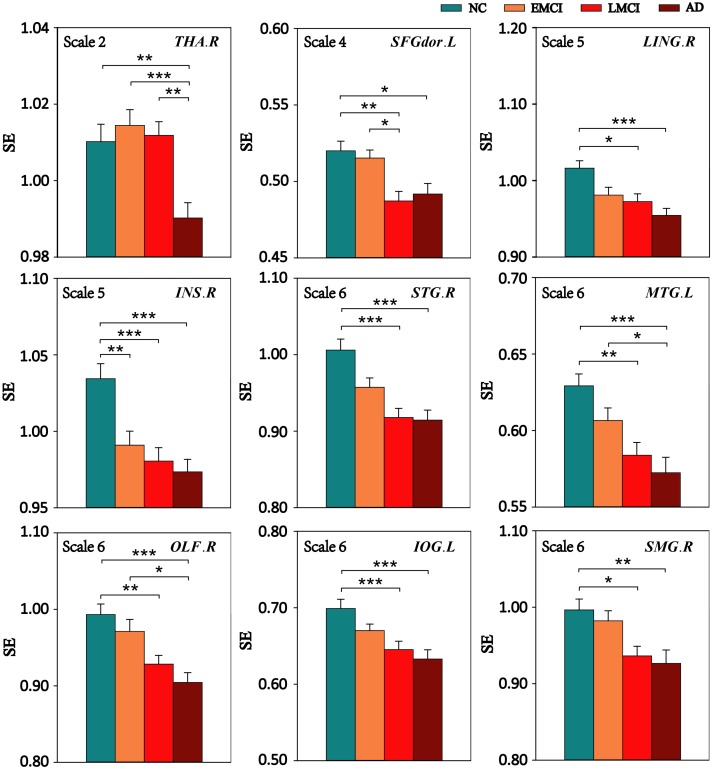
Mean SE values of the nine ROIs in the NC, EMCI, LMCI, and AD subjects on four time scales. Significant differences between pairs of groups after Bonferroni correction (p < 0.05) are indicated. The error bar represents the standard error of MSE within the group. ∗ indicates p < 0.05. ∗∗ indicates p < 0.01. ∗∗∗ indicates p < 0.001.